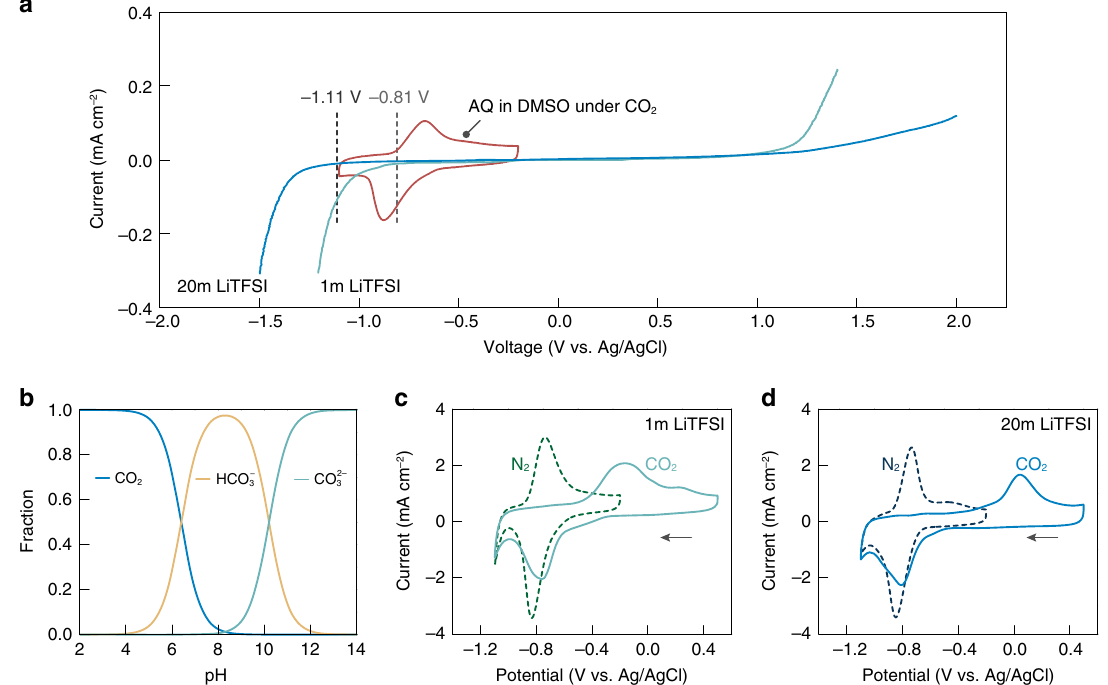
Fig. 2 Rational electrolyte formulation for quinone-mediated CO 2 capture in aqueous media. a Linear sweep voltammetry of 1 and 20m LiTFSI aqueous electrolytes at a rate of 1 mV s − 1 , compared with the CV of AQ under CO 2 . Glassy carbon was used as the working electrode. Cathodic and anodic scans were performed separately and joined together afterwards. b The Bjerrum plot of the carbonic acid equilibrium as a function of the solution pH for an ideal solution at 25 °C. c, d CV of PAQ-CNT in 1m LiTFSI ( c ), and 20m LiTFSI ( d ), under N 2 (dashed line) and CO 2 (solid line) at a rate 50 mV s − 1 . PAQ was cast on glassy carbon at a loading of 0.042 mg cm − 2 . For a , c , d , the electrochemical measurements were conducted with Pt wire as the counter electrode and Ag/AgCl as the reference electrode. Source data are provided as a Source Data fi